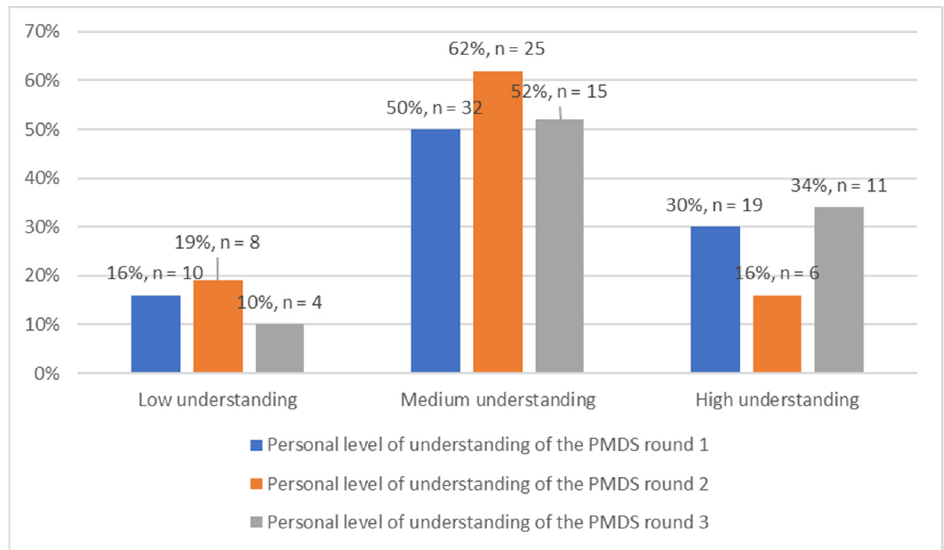
Figure 3. Personal level of understanding of the PMDS ( n = 135).